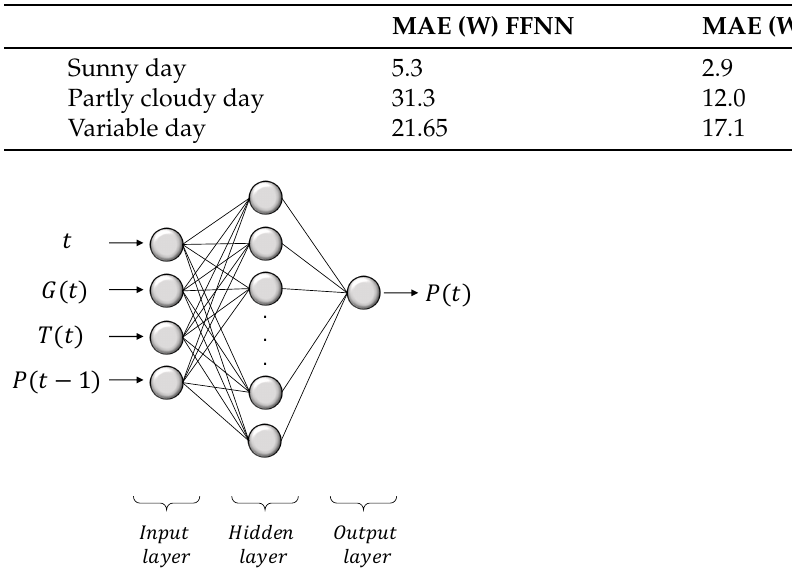
Figure 15. Dynamic Feed Forward Neural Network (D-FFNN)